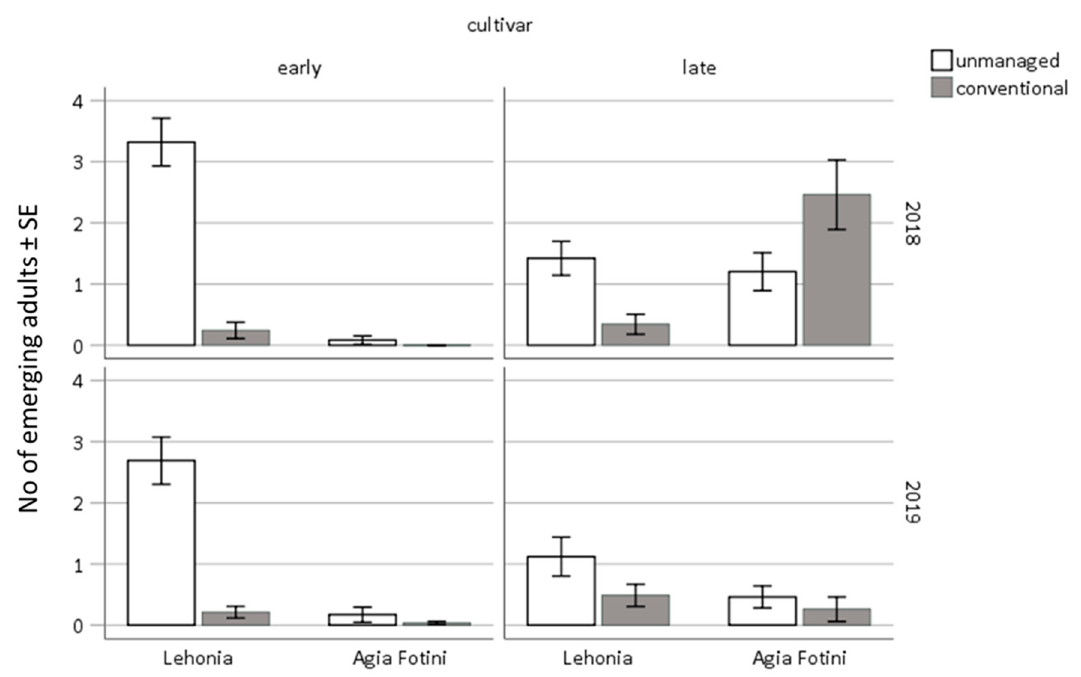
Figure 9. Adults emerging from field-infested sweet cherries, sampled from early- and late-ripening cultivars of unmanaged sweet-cherry trees and conventional commercial cherry orchards, located in Lehonia and Agia Fotini during 2018 and 2019.